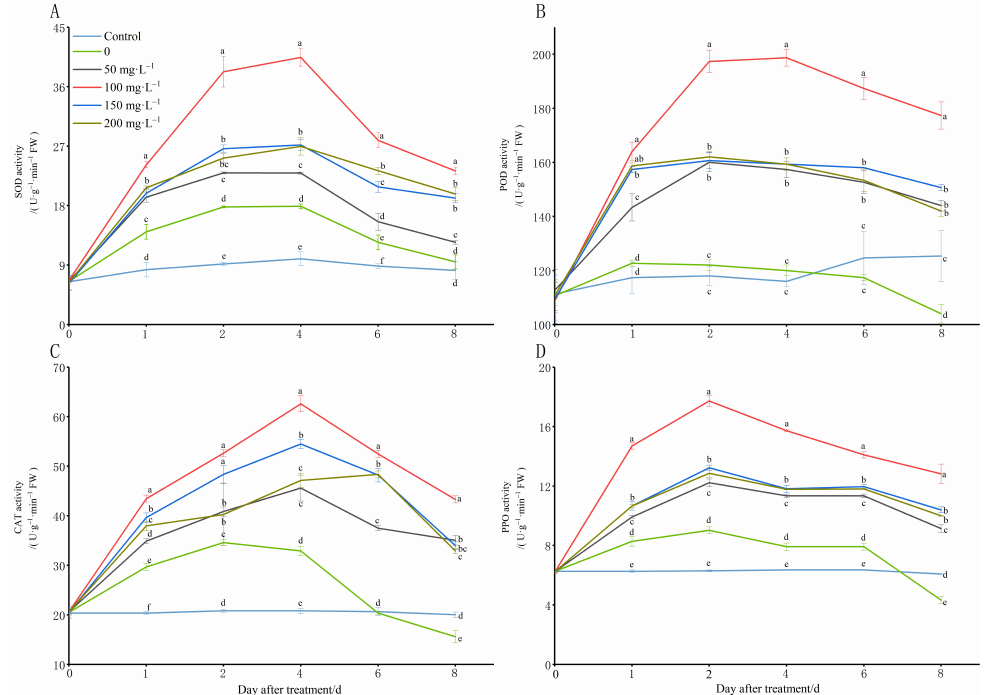
Figure 4. Changes in lipid peroxidation contents of peanut seedlings under low-temperature condi- tions (8 ◦ C). On each subgraph, different letters in the same column indicate significant differences in the p < 0.05 level. Data in the figure are presented as the mean ± standard deviation (n =